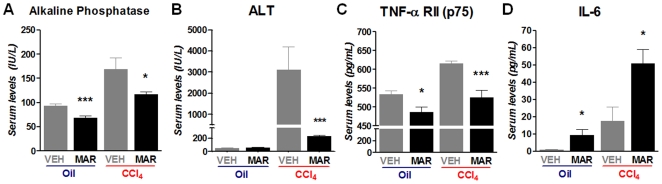
Marimastat treatment ameliorated hepatic injury and the inflammatory response following repeated carbon tetrachloride (CCl4) administration.Marimastat treatment significantly reduced serum alkaline phosphatase levels (A), and resulted in a 14-fold decrease of serum ALT (B), indicating decreased hepatic injury. Serum TNF-α receptor II (p75) levels as measured by ELISA decreased following Marimastat treatment, suggesting successful inhibition of TNF-α converting enzyme (TACE) and an ameliorated inflammatory response. IL-6 serum levels as measured by ELISA increased following Marimastat treatment, suggesting hepatoprotection and stimulated liver regeneration (D). Oil, non-fibrotic control group; CCl4, fibrotic mice; VEH, vehicle treated control group; MAR, Marimastat treated experimental group; ALT, alanine aminotransferase; TNF, tumor necrosis factor; IL, interleukin; *, P<0.05; ***, P<0.001 vs. vehicle alone. Data are expressed as means ± standard error.